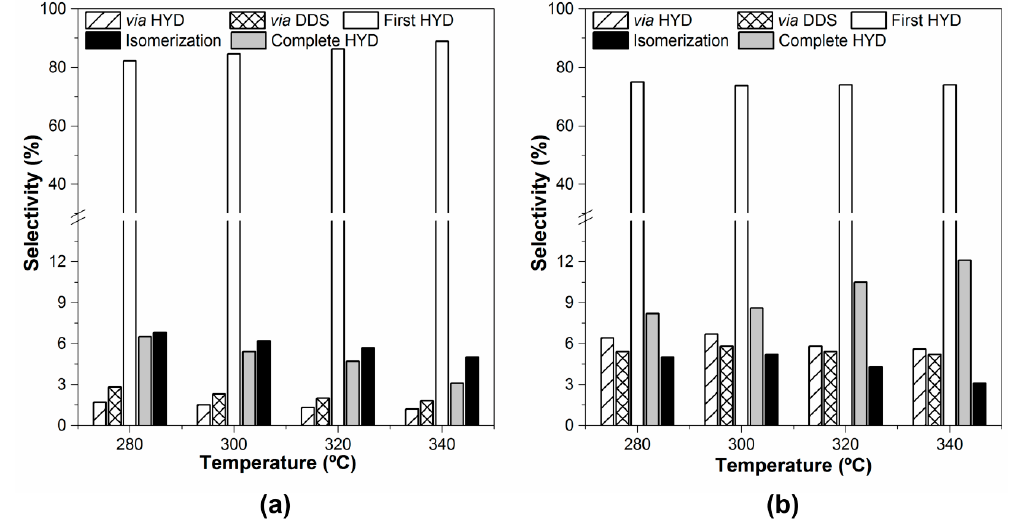
Figure 6. Selectivity taken to 20–25% of 3-methyl-thiophene conversion in ( a ) ReS 2 /C composite and ( b ) reference sulfided CoMo/ γ -Al 2 O 3 .